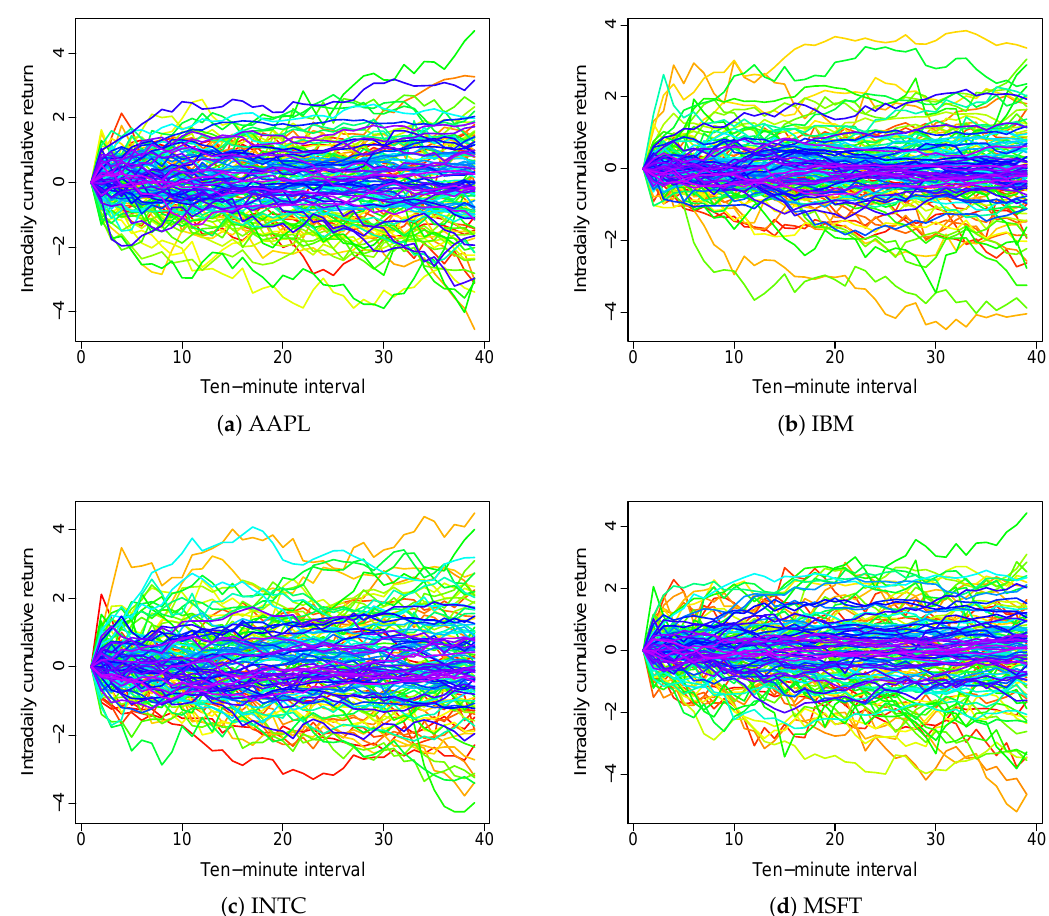
Figure 2. Functional time series of intraday cumulative returns of four selected tech companies. It is the differences in the color patterns and shapes of curves that make functional time series